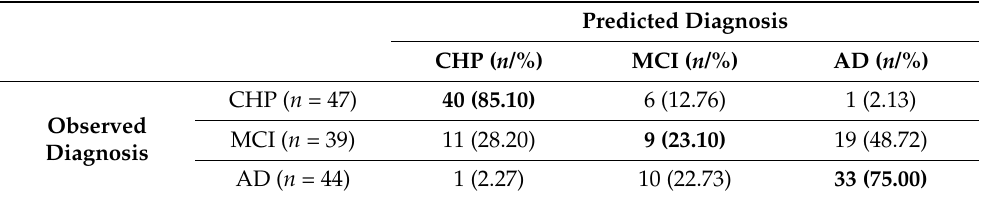
Table 2. Observed and predicted diagnosis based on the BIA. Table 2 . Observed and predicted diagnosis based on the BIA .